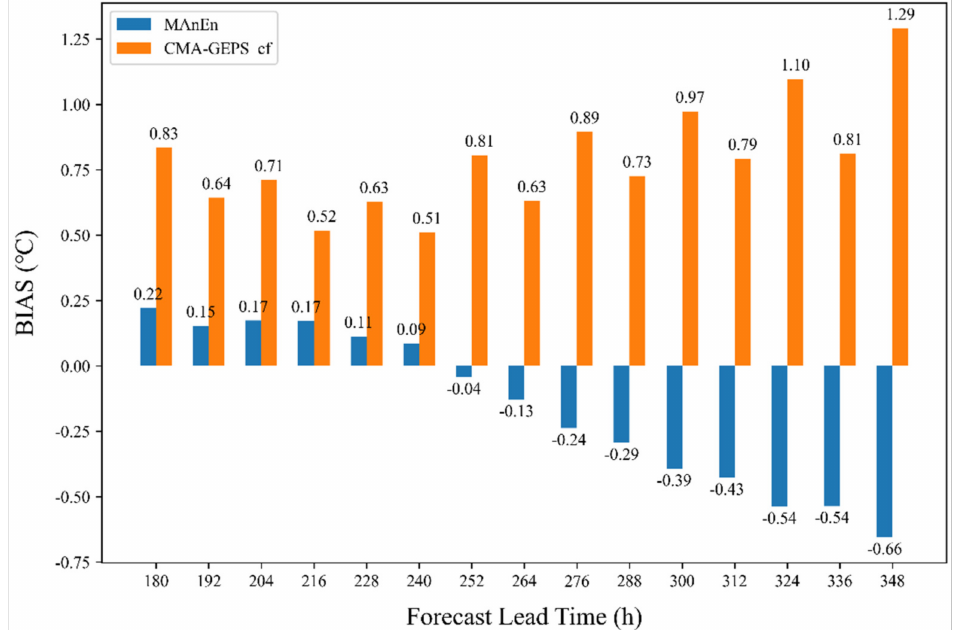
Figure 2. The biases of 2-m temperature between analogue ensemble averaging forecasts and model forecasts for the forecast lead times of 180–348